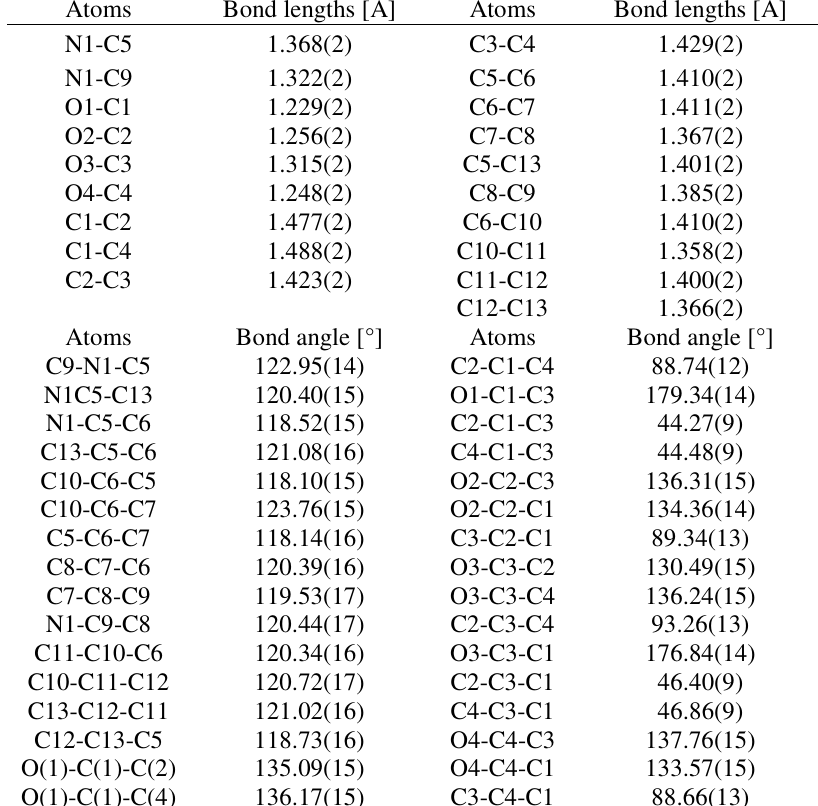
Table 2. Selected bond lengths (Å) and bond angles (°) for the title compound Atoms Bond lengths